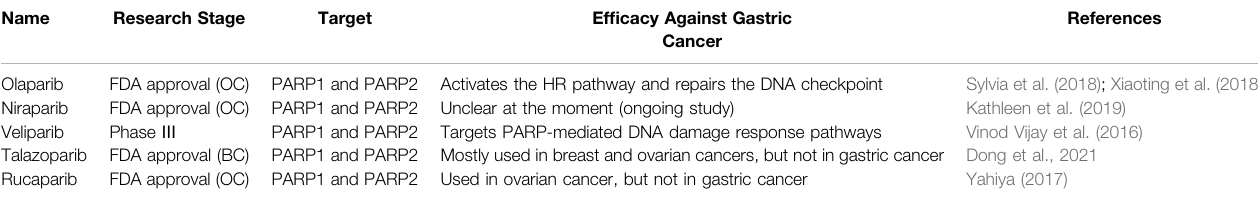
TABLE 2 | A summary of fi ve PARP inhibitors in clinical and preclinical